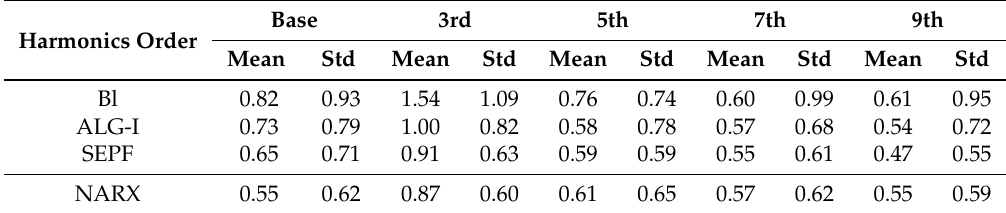
Table 4. Mean square errors of the transient harmonic measurement accuracy